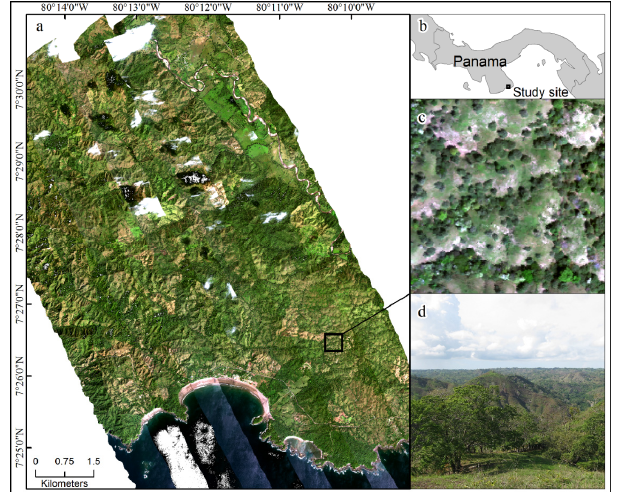
Figure 1. Images of the Azuero Peninsula study site. ( a ) Carnegie Airborne Observatory (CAO) true-color image of 23,000 ha; ( b ) Location of the study site; ( c ) Agricultural tree cover shown in a true-color image of the CAO image with 2-m spatial resolution; ( d ) Typical tree cover on agricultural land.